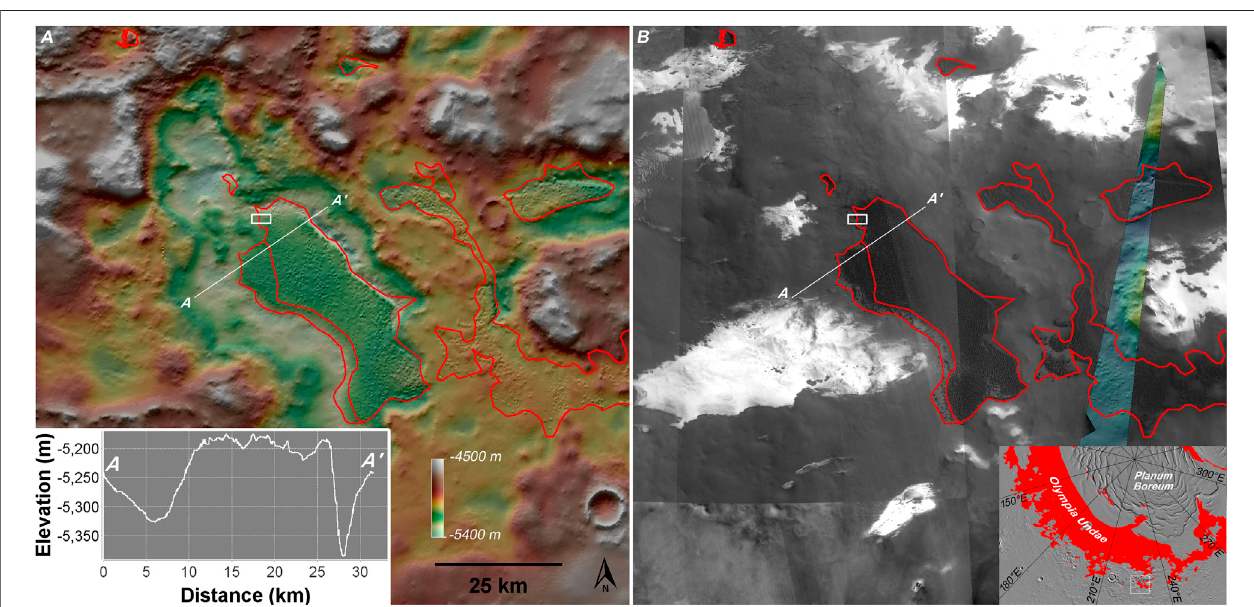
FIGURE2| Thestudyareashownon (A) MOLA512pixelperdegreehillshade(Smithetal.,2003)and (B) CTXglobalmosaic(Dicksonetal.,2018).Insetsshowthe elevation pro fi leforthelinefromAtoA ′ andtheregionalcontextofthedune fi eld.RedoutlinescorrespondwithMGD 3 dune fi eldoutlines(Hayward,2011),andthewhite boxes indicate the location of Figure 1A . The fi gure was made using Java Mission-planning and Analysis for Remote Sensing (JMARS; Christensen et al., 2009).